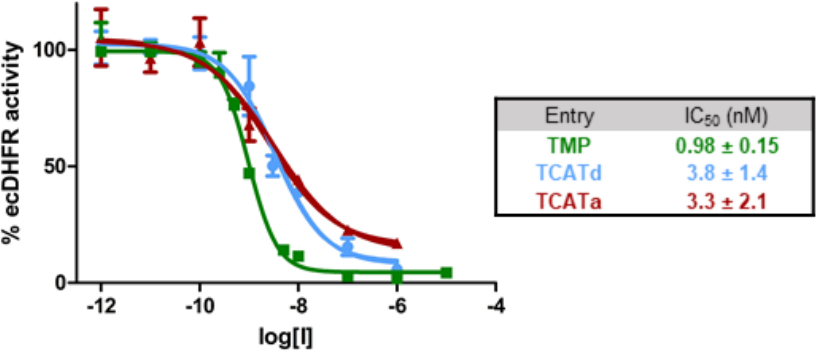
Figure 2. Dose–response curves for TCATd (blue, >99% trans -TCAT), TCATa (red, 87:13 cis : trans distribution) and TMP (green) against E. coli